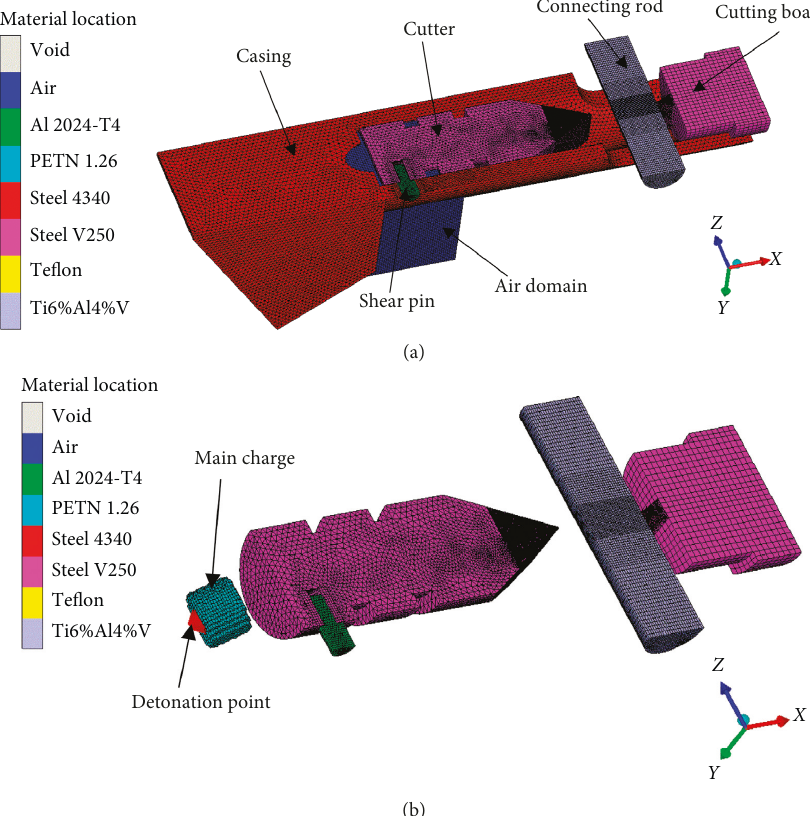
Figure 4: Finite element division effect diagram of the simplified model. (a) Model of the pyrotechnic cutter. (b) Detonation point. Table 2: Material parameters of 4340 stainless steel. Table 1: Material parameters of PETN. Parameters Value